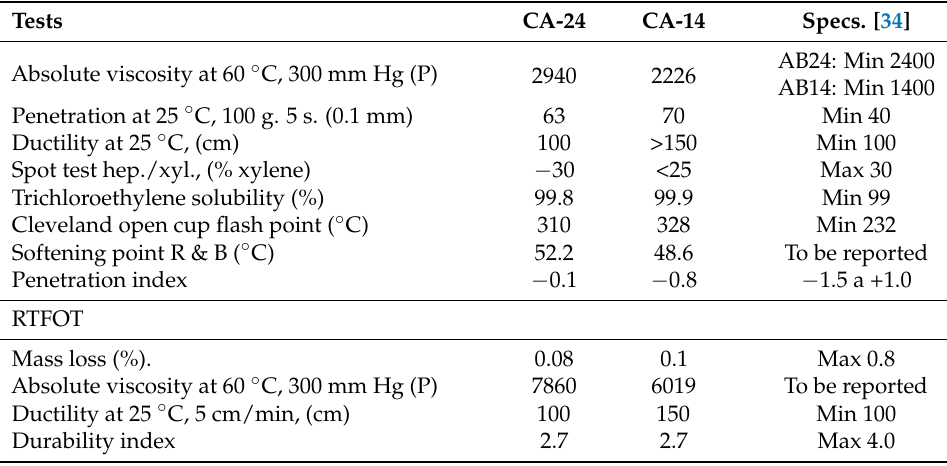
Table 2. Properties of the asphalt binders